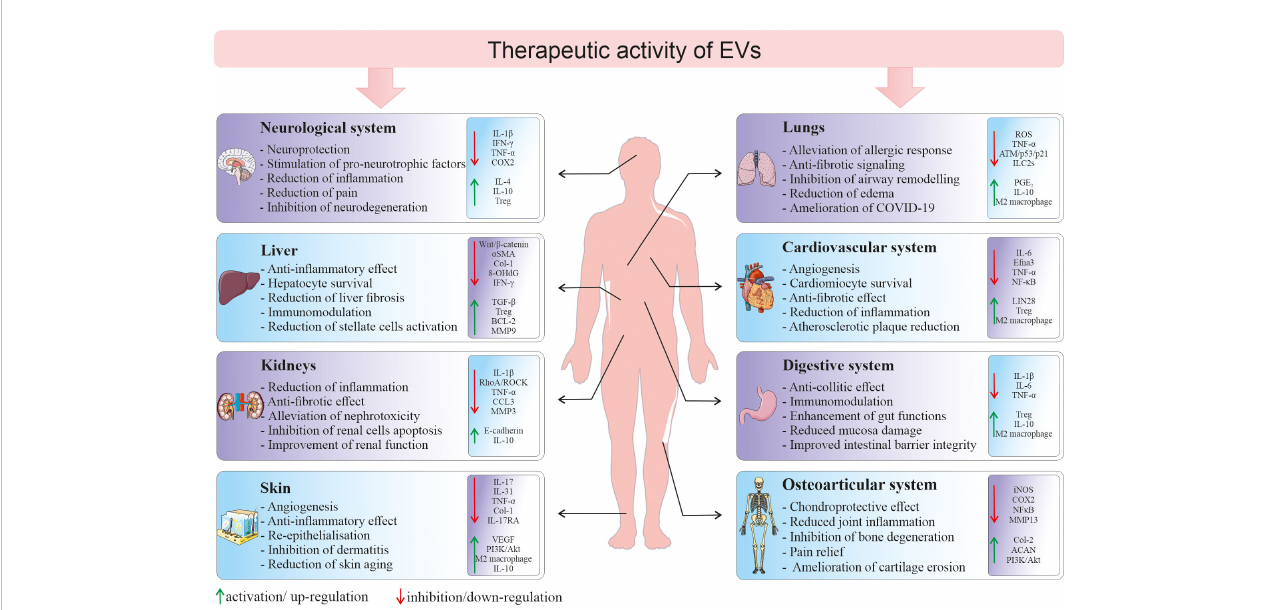
FIGURE 4 Therapeutic activity of EVs in different tissues and organs. Depending on a type of tissue/organ as a site of vesicle delivery, EVs they may modulate several cellular processes and signaling pathways in the local environment, leading to the tissue regeneration in the place of injury. 8-OHdG, 8-hydroxyguanosine; ACAN, aggrecan; BCL-2, B-cell CLL/lymphoma 2; CCL3, macrophage in fl ammatory protein-1 a ; Col, collagen; COX2, cyclooxygenase-2; Efna3, ephrin A3; IFN- g , interferon gamma; ILC2s, type 2 innate lymphoid cells; iNOS, inducible nitric oxide synthase; MMP, metalloproteinase; NF- k B, nuclear factor kappa-light-chain- enhancer of activated B cells; PGE 2 , prostaglandin E2; ROS, reactive oxygen species; TGF- b , transforming growth factor b ; TNF- a , tumor necrosis factor alpha; Treg, regulatory T cells; VEGF, vascular endothelial growth factor; a SMA, alpha smooth muscle